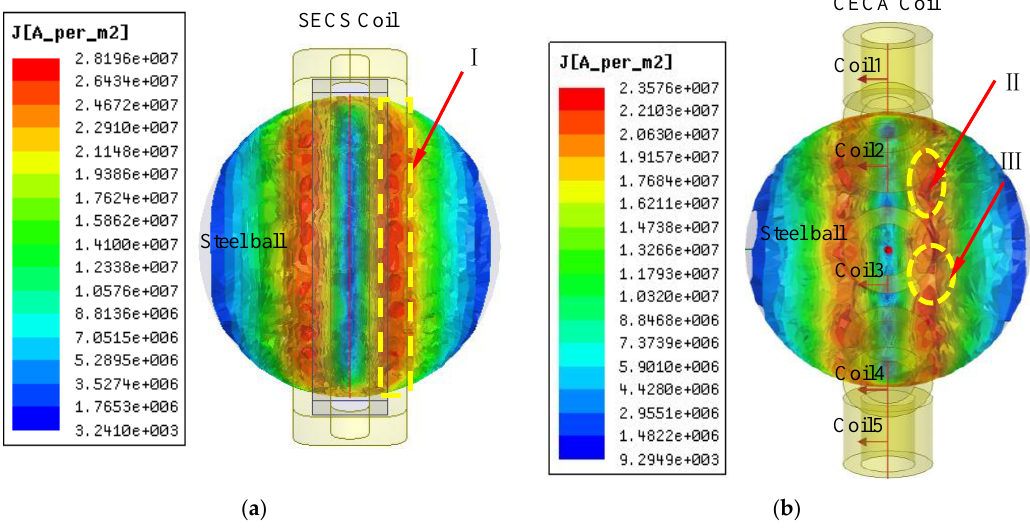
Figure 6. Eddy current density distribution on a steel ball surface. ( a , b ) Eddy current density distributions on a steel ball surface induced by SECS and by the five-coil CECA sensor, respectively.